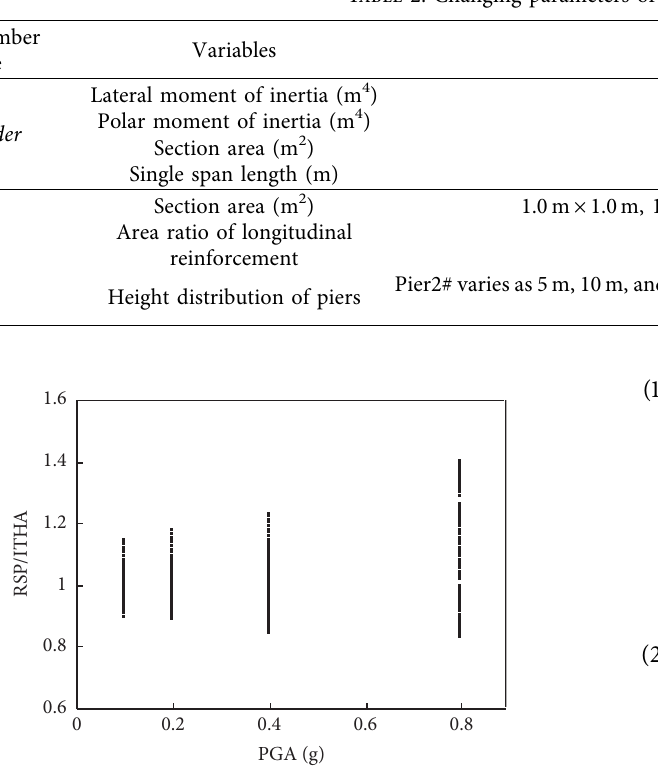
Figure 9: Ratio of seismic displacement of the simplified prediction method using RSP to that of